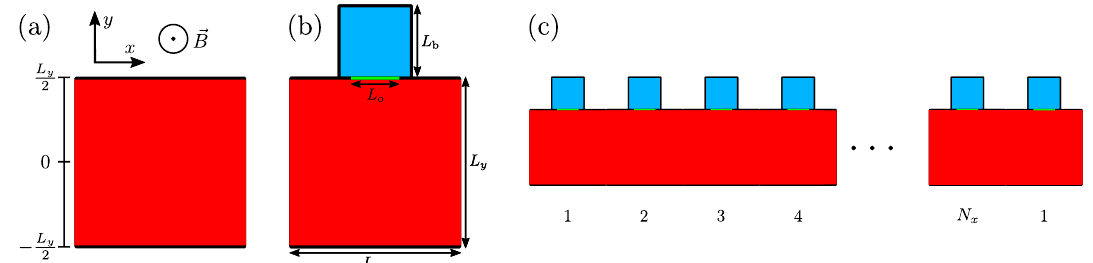
Figure 2: Sketch of the considered geometries of increasing complexity. Panel (a) displays the standard IQHE sample without any decoration of the boundaries; its width is denoted by L and its total length by L . Periodic boundary conditions in x -direction are assumed. Panel (b) x shows the single unit considered where the dimensions of the bay and the coupled bulk are given. Note the opening of the bay shown in green; its width is denoted by L sample consists of N such units as shown in panel (c) so that L x